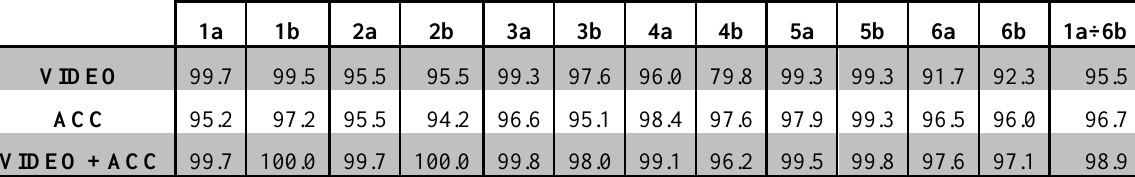
Table 3. Recognition correctness of examined physical activities (1a ÷